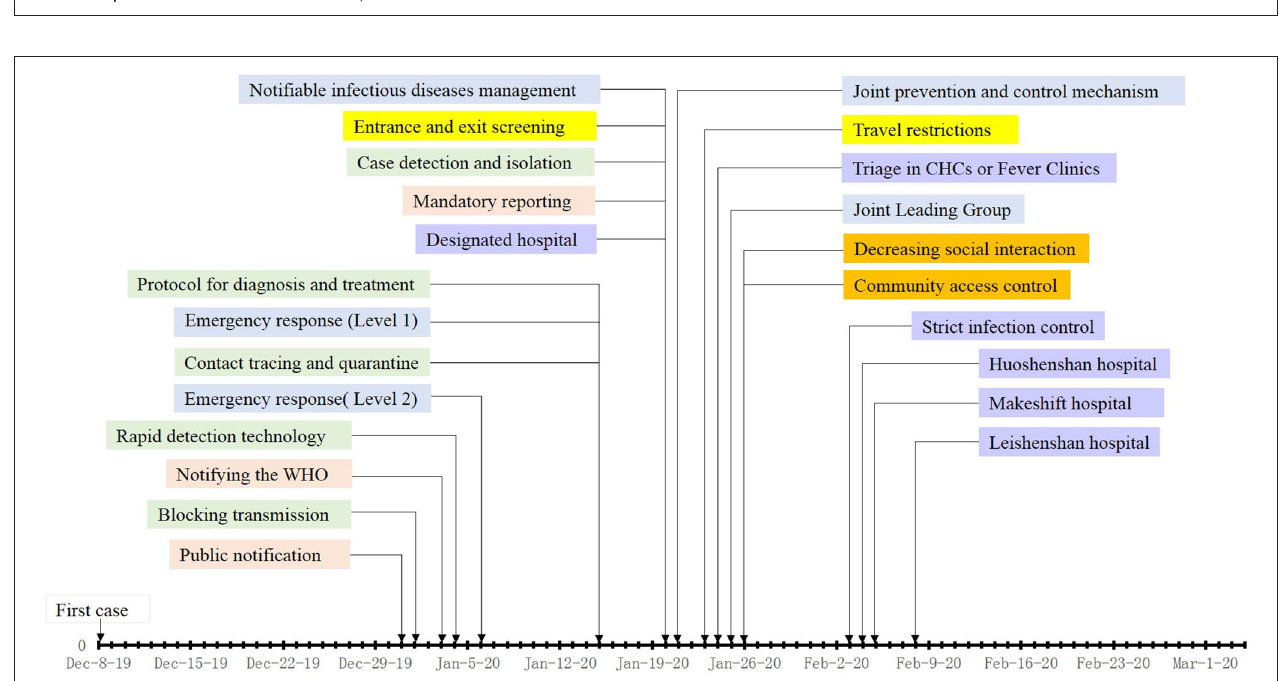
FIGURE 1 | Timeline of control measures implemented in SARS.